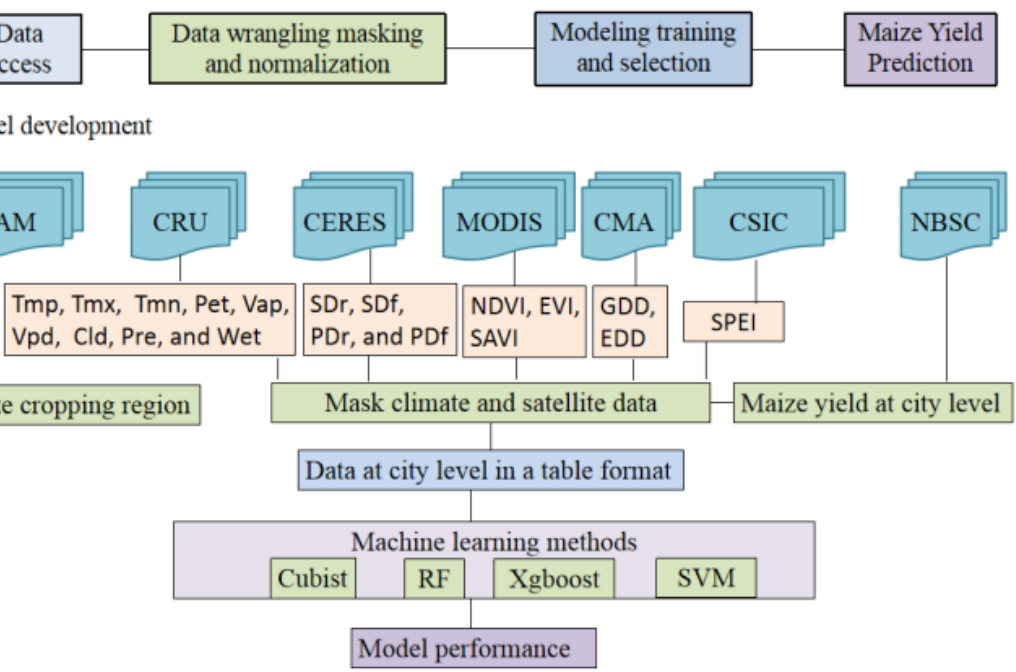
Figure 2. Flowchart indicating all steps of the model development.